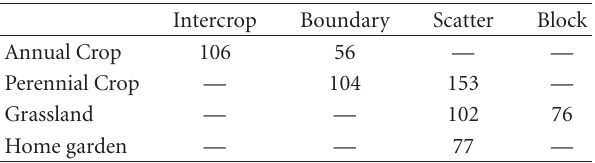
Table 4: Tree distribution by planting niches and designs of native trees measured in Manlawaan, Leyte.